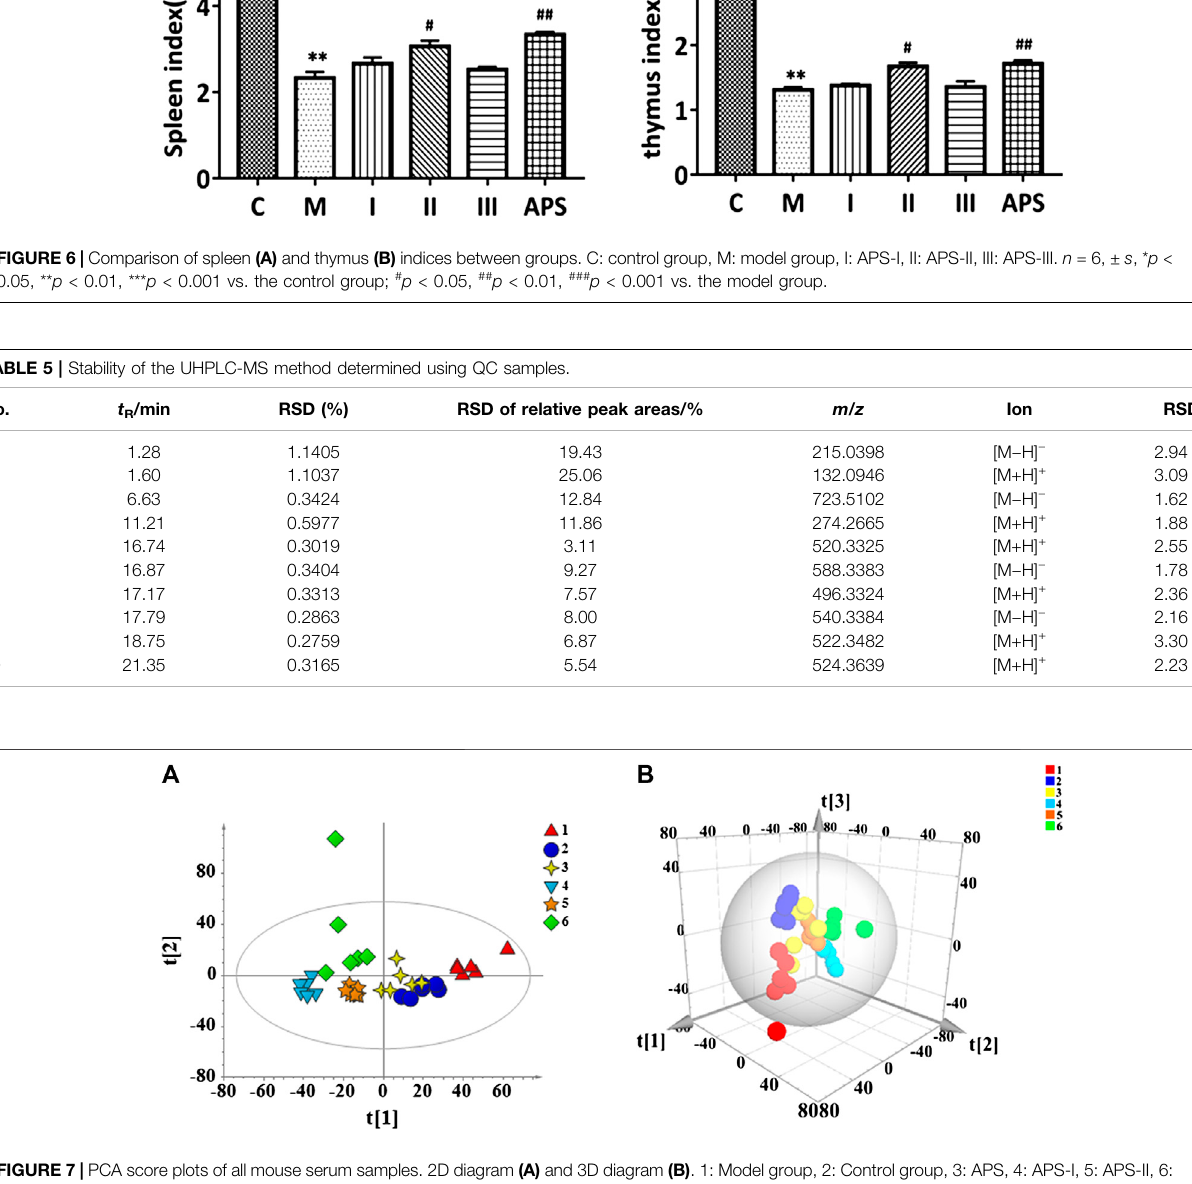
Frontiers in Pharmacology |